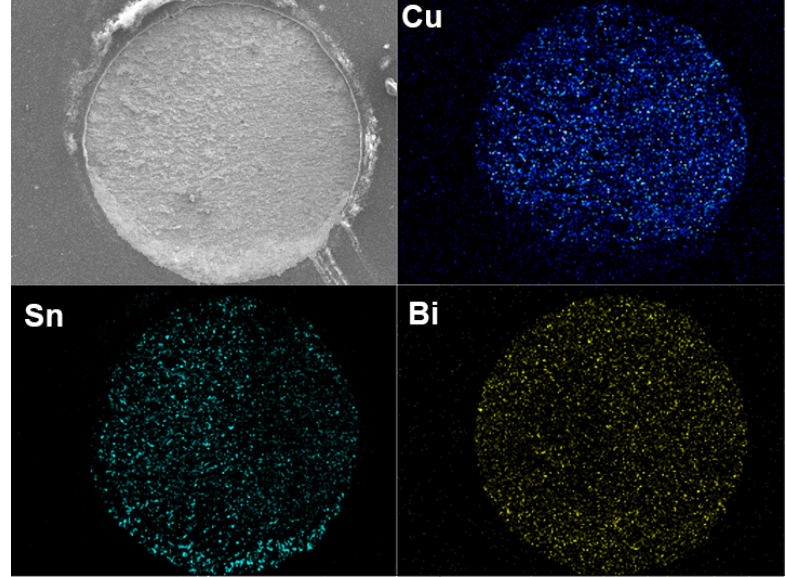
Figure 10. Illustration on a typical brittle fracture mode with the elemental mapping of Sn-58Bi joint after aging for 40 days.